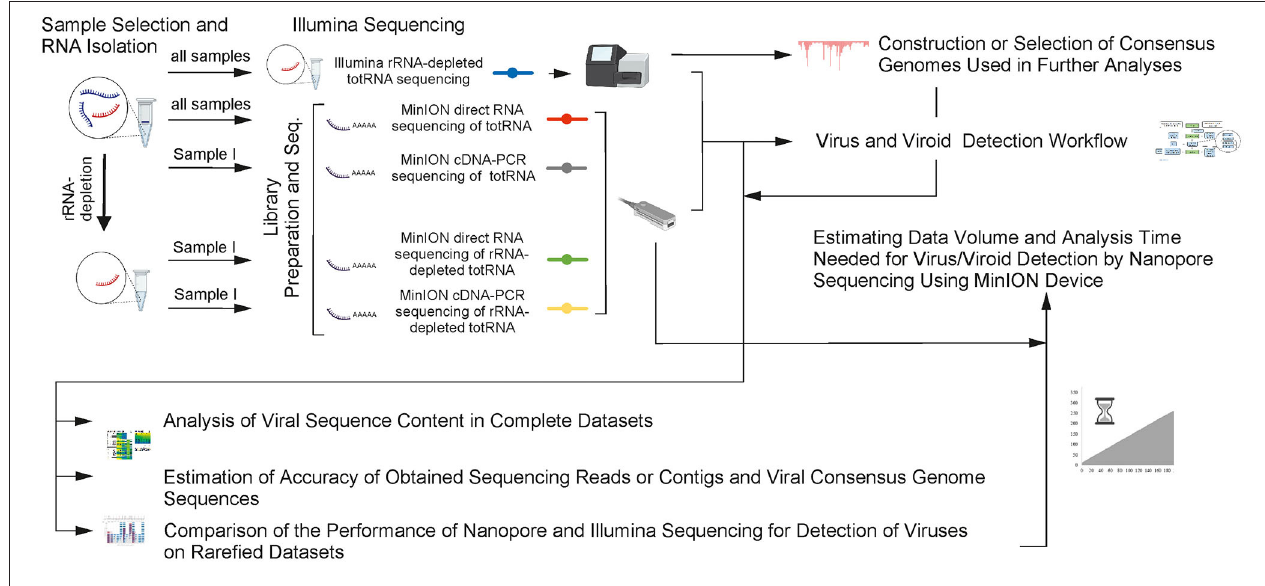
FIGURE 1 | An overview of the conducted study. Listed titles of chapter material and methods are connected with arrows according to the course of work (part of the figure was created with